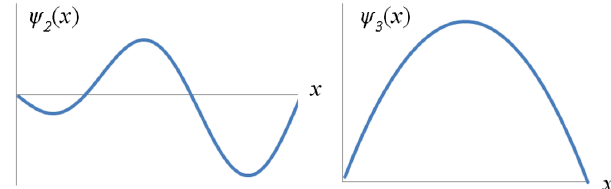
FIG. 2. Graphs that were provided to students for the wave functions ψ 2 ð x Þ and ψ 3 ð x Þ